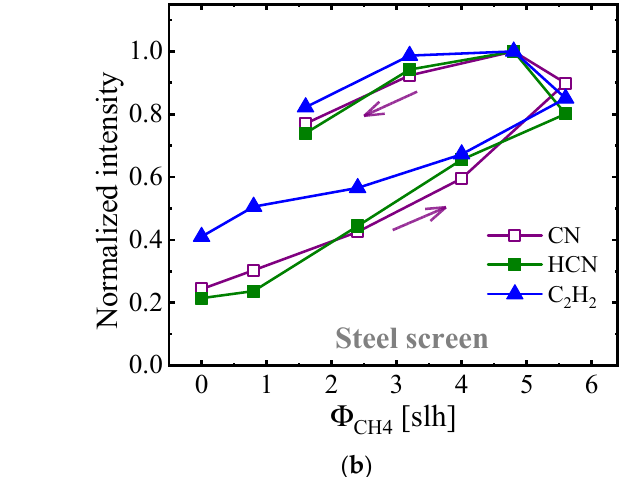
comparison of normalized signals of CN from high-resolution OES and HCN and C 2 H 2 from LAS ( b ) during ASPNC treatment using a steel AS at H 2 :N 2 = 1:1, p = 3 mbar, T = 460 °C, Φ Total = 80 slh, and P Bias = 1.25 kW. Lines are guides for the eye and arrows indicate the order of measurements.